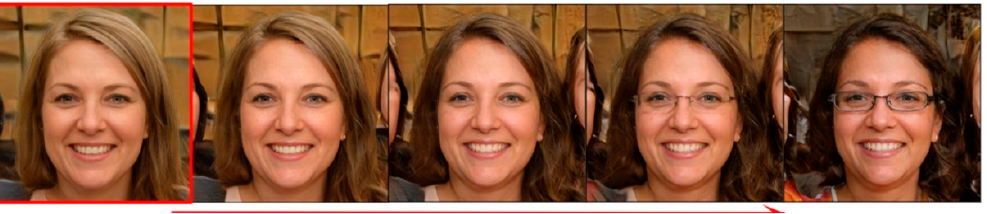
Figure 8. The result of editing the semantic attribute of glasses without local contrast